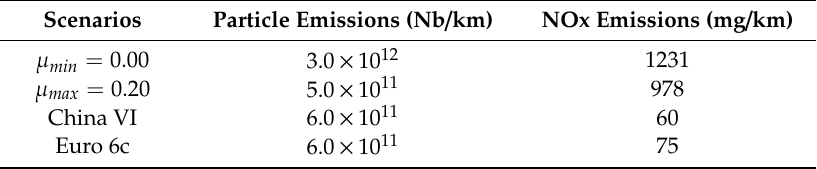
Figure 15. The combination of simulation results of the series of discrete values µ . Table 5. Comparison between simulation results and the latest emission